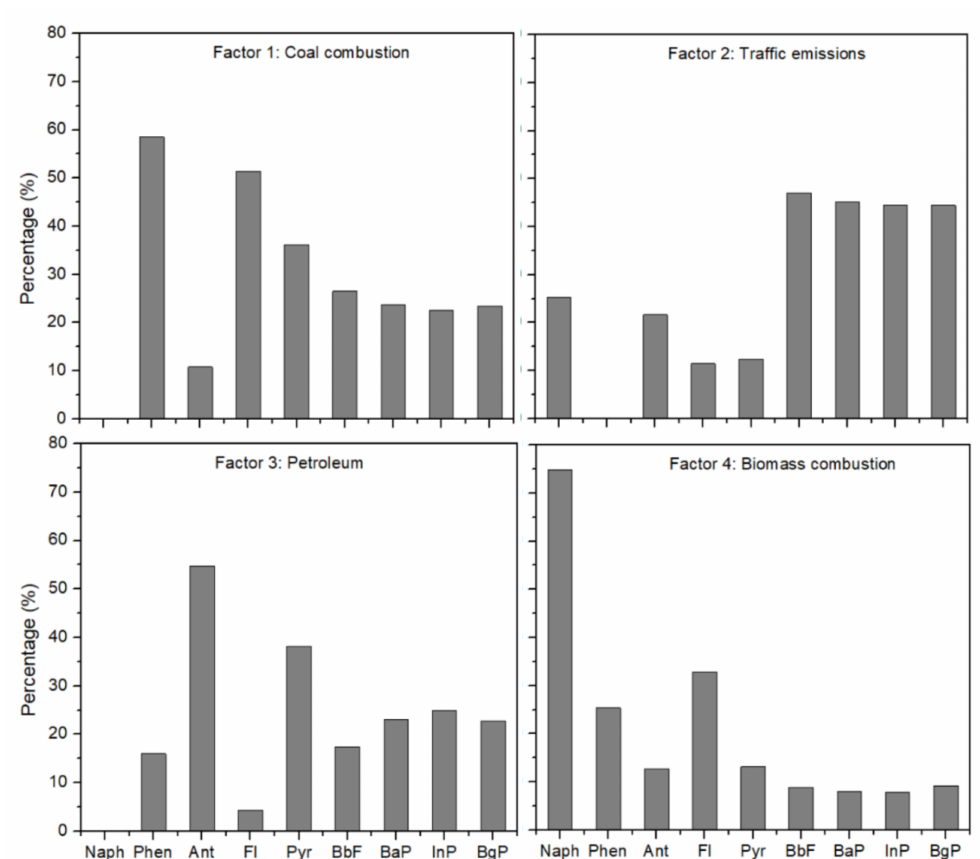
Figure 6. Four main source components of sedimentary polycyclic aromatic hydrocarbons (PAHs) obtained using a positive matrix factorization (PMF) model for Dongping